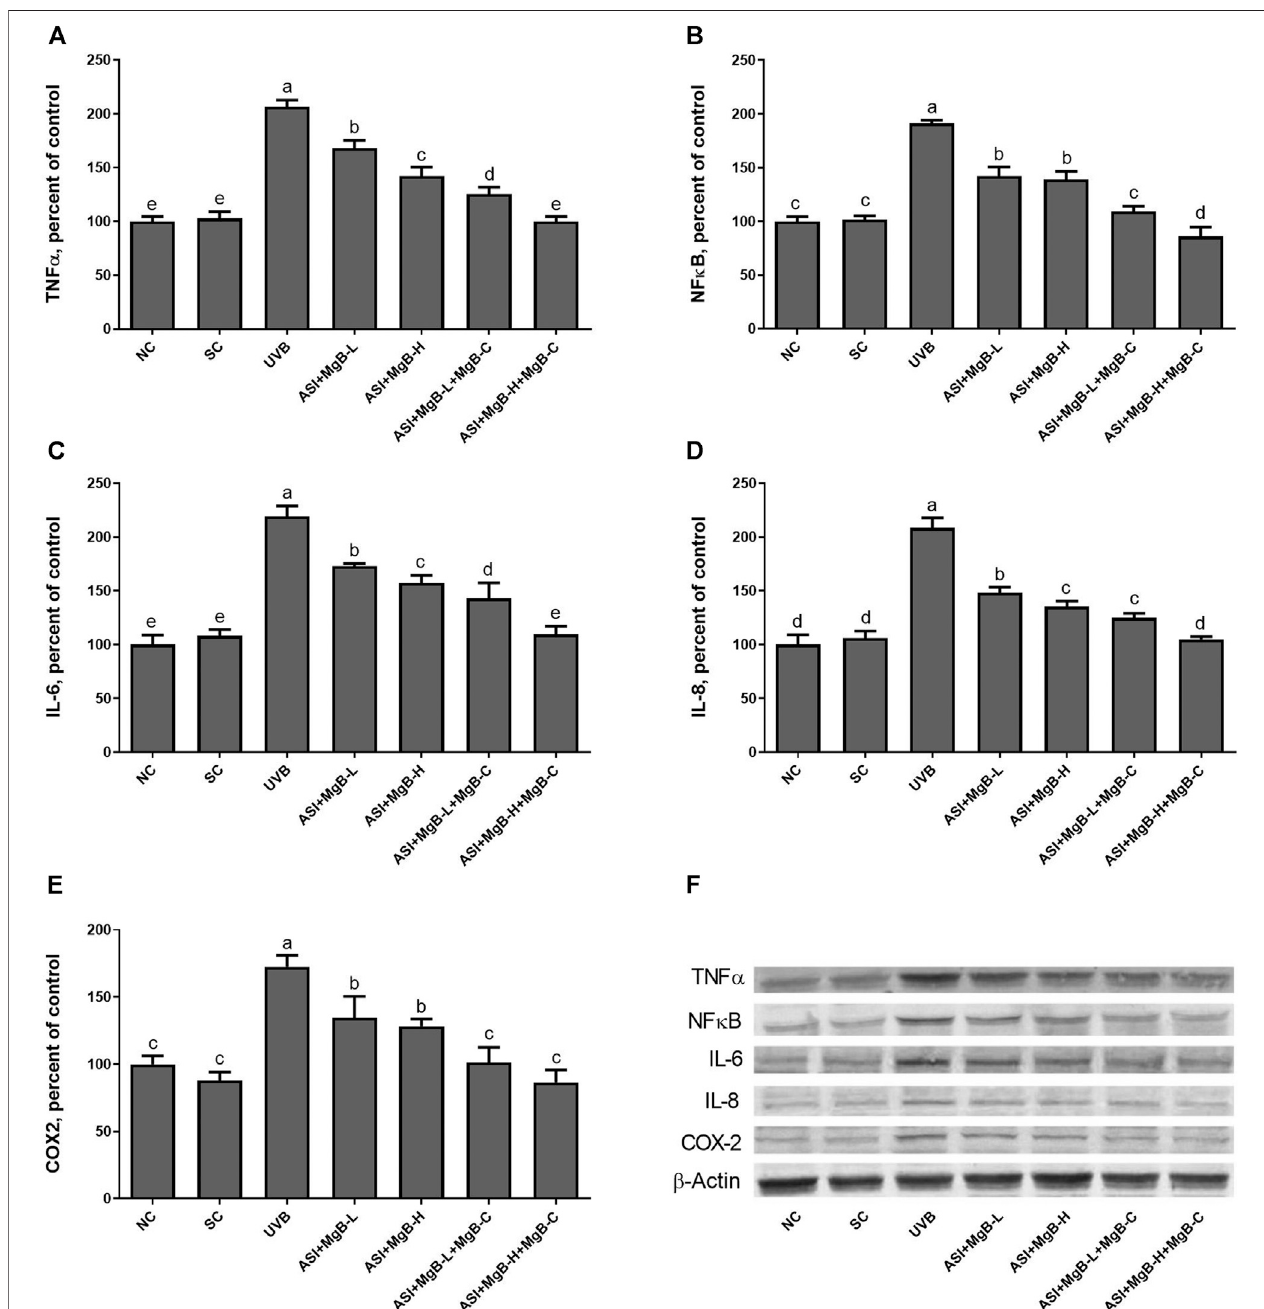
FIGURE 5 | Effect of inositol-stabilized arginine silicate complex (ASI) and magnesium biotinate (MgB) on tumor necrosis factor-alpha (TNF- α ; A ), nuclear factor- kappaB(NF- κ B; B ),interleukin6(IL-6; C ),interleukin8(IL-8; D ),andcyclooxygenase(COX-2; E )proteinlevelsinratswithUVB-inducedphotoaging.Dataareexpressed as a percent of the control value. Each bar represents the mean and standard error of the mean. Blots were repeated at least 3 times. Western blot analysis was performedwithactinincludedensuringequalproteinloading (F) .Thedataarepercentagesofthecontrol. a – e :Valueswithinthebarswithdifferentsuperscriptsare signi fi cantly different (One-way ANOVA and Tukey ’ s post-hoc test, p <